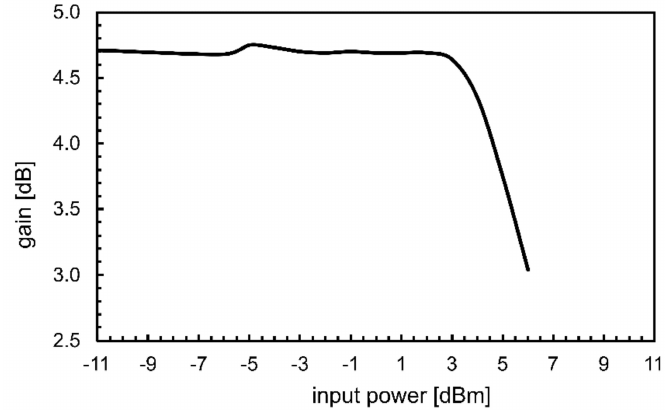
Figure 8. Measured in-band gain as a function of the input